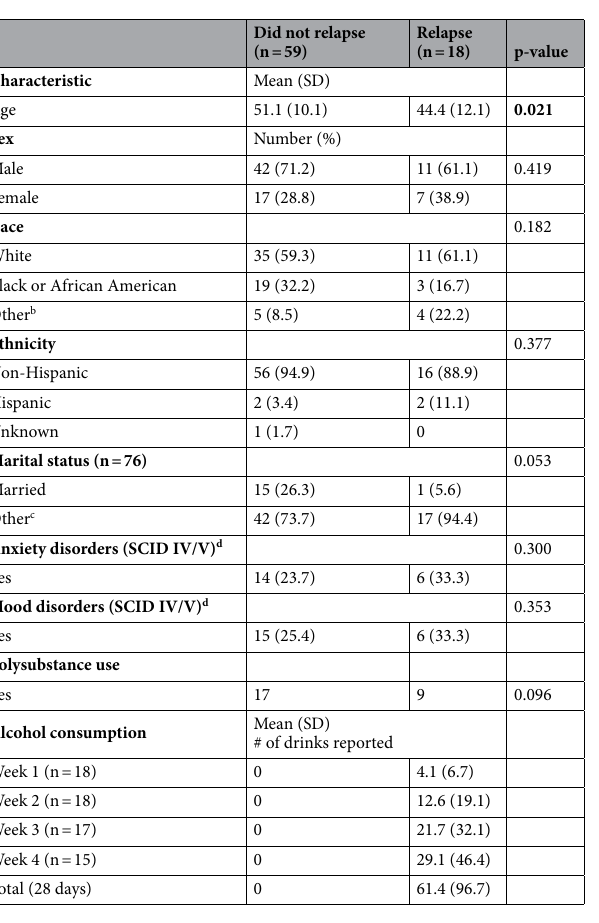
Table 1. Patient population demographics (N a = 77). Significant values are in [bold]. a Total number of participants with valid data and included in the analysis based on filtering rules. b Other includes American Indian, Asian, Multiracial and other. c Other includes divorced, separated, single, or widowed. d Diagnosis of one or more disorder according to Structured Clinical Interview for DSM-IV/5